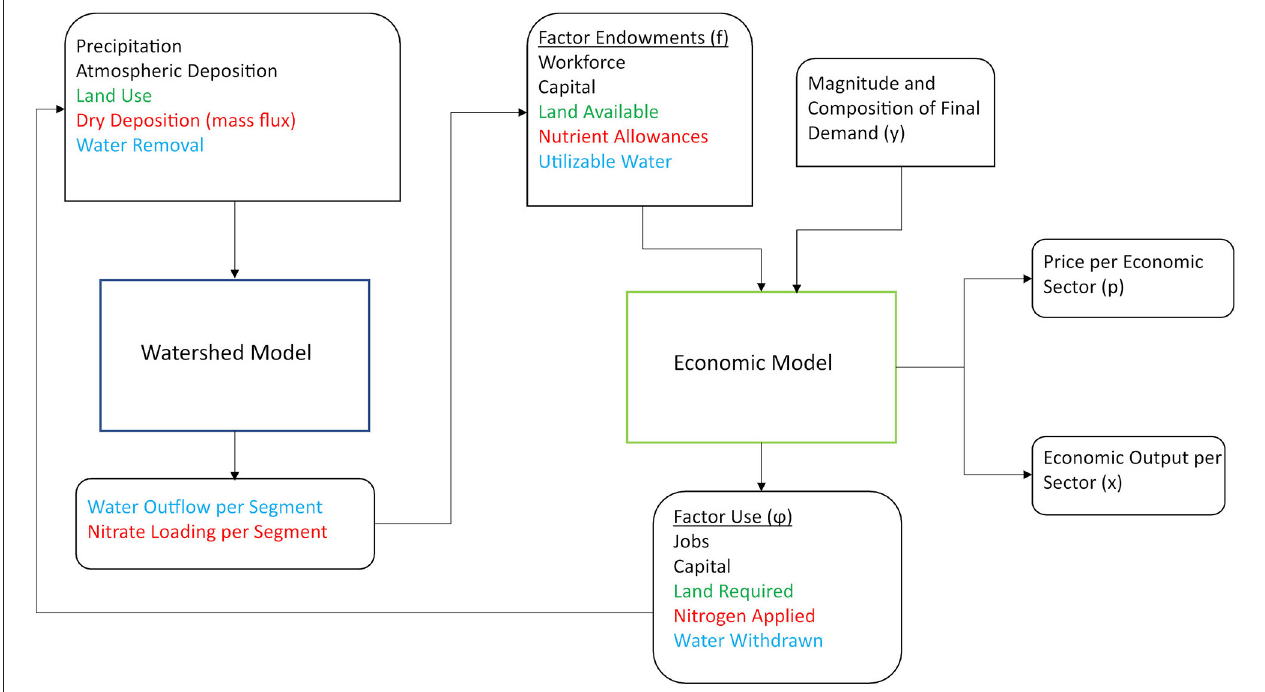
FIGURE 3 | Conceptual modular framework for coupling a constrained optimization economic model (RCOT) with a watershed model (HSPF). Green- units of land use, Red- units of nitrogen, Blue- units of water, Sharp-edged rectangles- modeling software, Soft/Sharp-edged rectangles- model inputs, Soft-edged rectangles- model